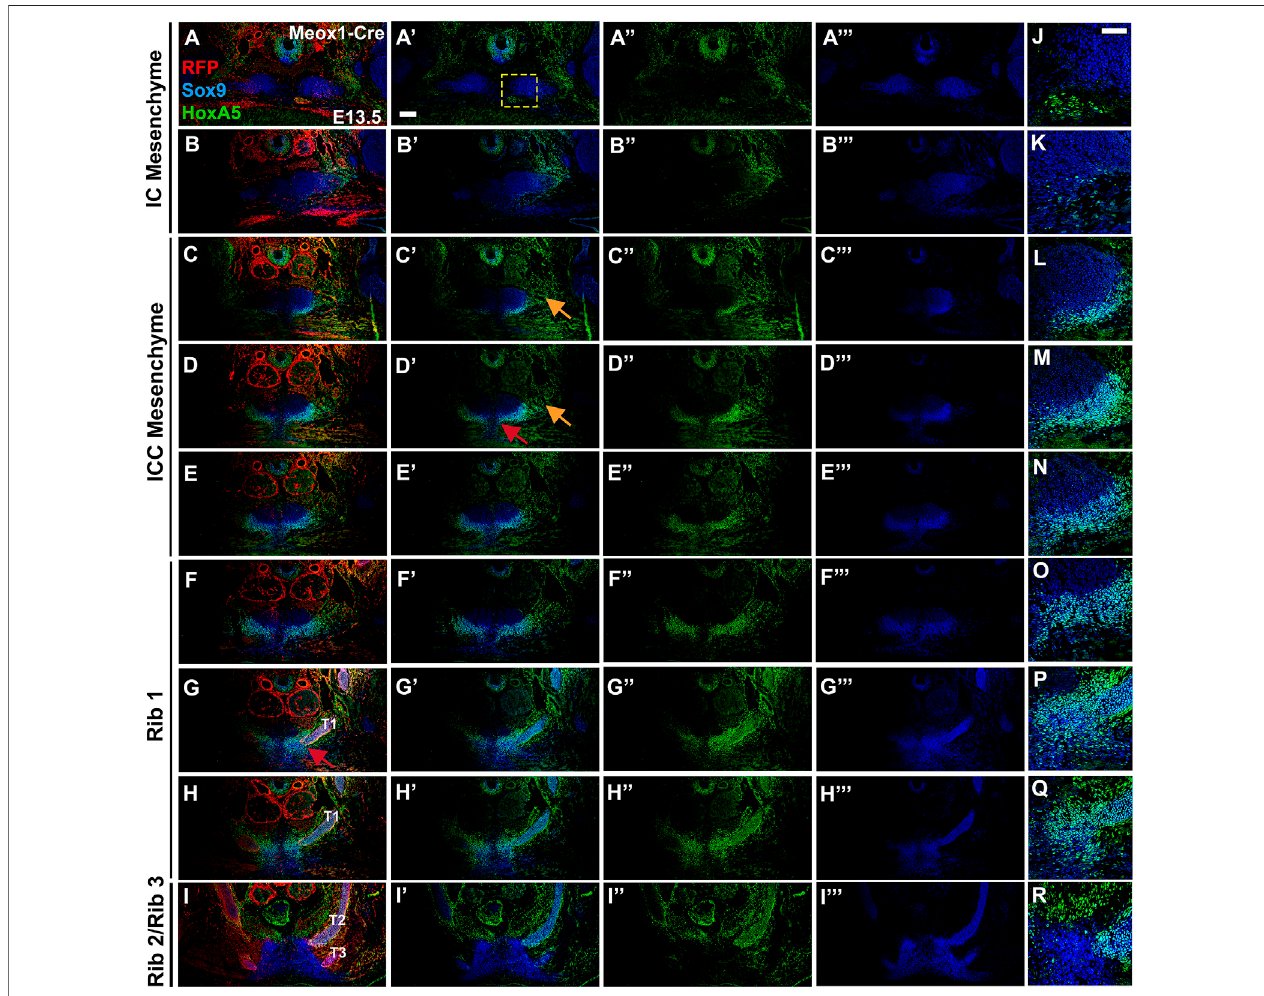
FIGURE 6 | At E13.5, HOXA5 and SOX9 co-expression identi fi es a component of the presternum that is continuous with the sternal bars, and is the site of rib 1 attachment. (A – I - ) E13.5 Meox1-Cre-RFP embryo co-labelled for HOXA5 (green (A 9 ,A ″ – I 9 ), SOX9 (blue, (A 9 ,A ‴ – I 9 ,I ‴ ) ), and RFP (red (A – I) ). As observed at E14.5, HOXA5, and SOX9 are co-expressed (cyan cells, (A,A 9 – I,I 9 ) in the ventral ICC element of the presternum — with HOXA5 expression extending more broadly ventral to SOX9 (C ′ – E ′ ; L – N) . (J – R) At higher magni fi cation (corresponding to yellow square in (A ′ ) ), co-expression is more clearly visualized. SOX9, but not HOXA5, is detectedatlowerlevelsinthedorsalICandICC (A ′ – E ′ ) ,whilebothareco-expressedinribs1and2 (F ′ – I ′ ) andspanningthesiteofrib1-to-sternumfusion (F ′ – H ′ ; O – Q) . HOXA5isadditionallyfoundintheperichondriumofribs1and2 (G ′ – I ′ ) ,aswellasintheconnectivetissueoftheinfrahyoidmuscles,dorsaltothesternum (I ″ ) .Redarrow in (D ′ ) indicatesexclusionofHOXA5fromthemostmedialregionoftheventralICCmesenchyme.Orangearrowsin (C ′ ,D ′ ) pointtoportionofHOXA5lateraldomainthat does not co-express with SOX9. Red arrow in (G) indicates site of rib 1 attachment. Scale bars: 200 μ M T1, thoracic rib 1; T2, thoracic rib 2; T3, thoracic rib 3.